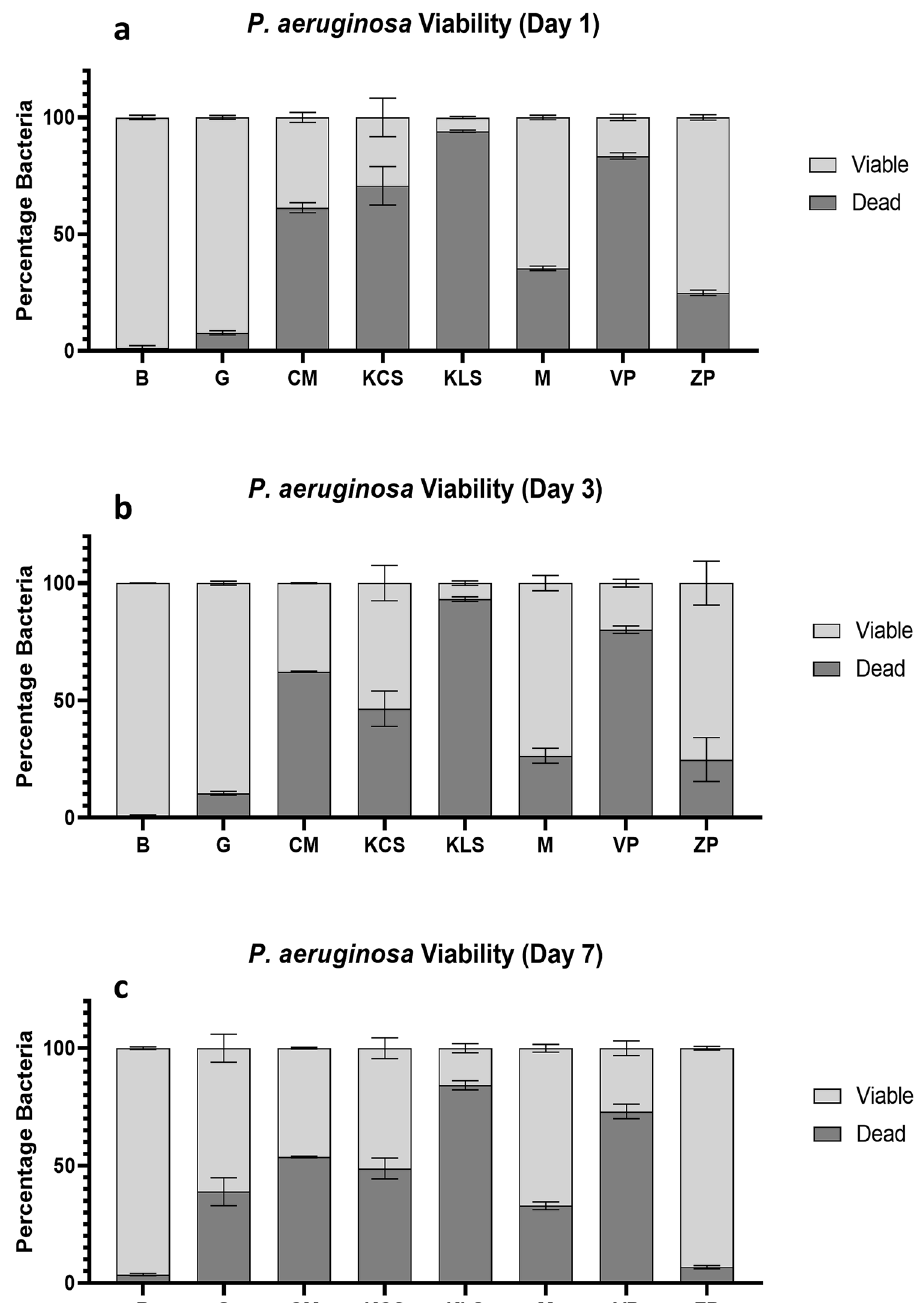
Figure 6. Viability of Pseudomonas aeruginosa in superabsorbent dressings. Superabsorbent wound dressings were inoculated daily with 1 * 10 7 CFU/ml of Pseudomonas aeruginosa , over 7 days in triplicate. On 1 ( a ), 3 ( b ) and 7 ( c ) days of inoculation, dressings were lysed and stained with a bacterial viability kit, to determine viability via flow cytometry. The following dressings were tested: Gauze (G), ConvaMax Superabsorber (CS), 3M Kerramax Care Super-Absorbent Dressing (KCS), Kliniderm Superabsorbent (KLS), Mextra Superabsorbent (MS), Vliwasorb Pro (VP) and Zetuvit Plus (ZP). A broth control was included (B). Data are shown as mean (+ /− SEM). Figure produced in GraphPad Prism V8 and data were analysed using FlowJo